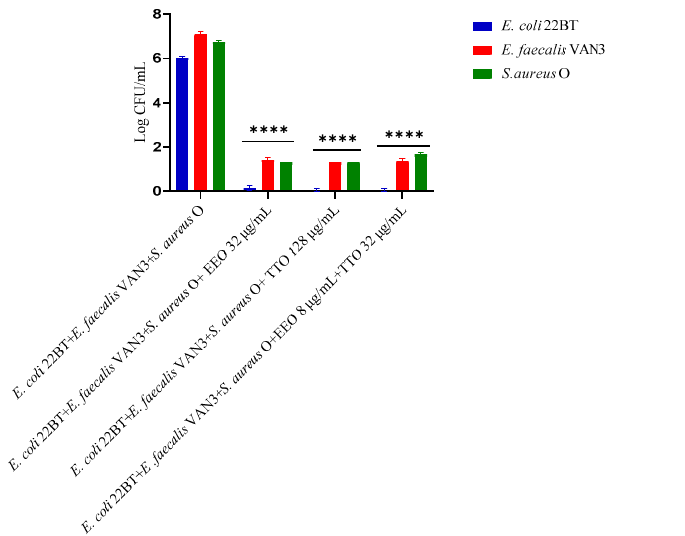
Figure 4. Quantification of viable cells in multi-species biofilm formation using Melaleuca alternifolia (TTO), Eucalyptus globulus (EEO) EOs and the association EEO/TTO. Results were expressed in Log CFU/mL as the arithmetic mean of the three determinations. p -values of <0.05 (*), p < 0.01 (**), p < 0.001 (***) and p < 0.0001 (****) were considered significant by ANOVA test.